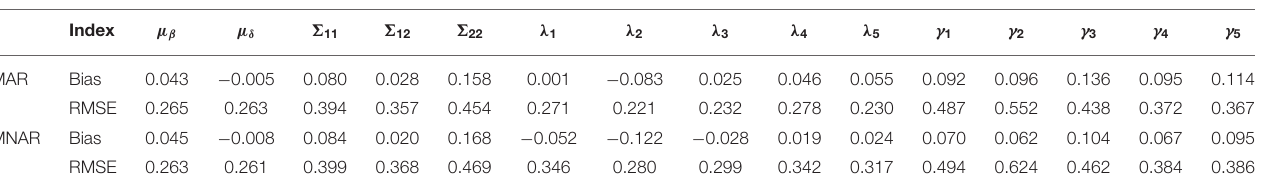
FIGURE 5 | The correct classification rates for each attribute and attribute profiles. HM, high missingness; LM, low missingness. TABLE 3 | Recovery of the item mean vector, the item covariance matrix, the attribute slope, and